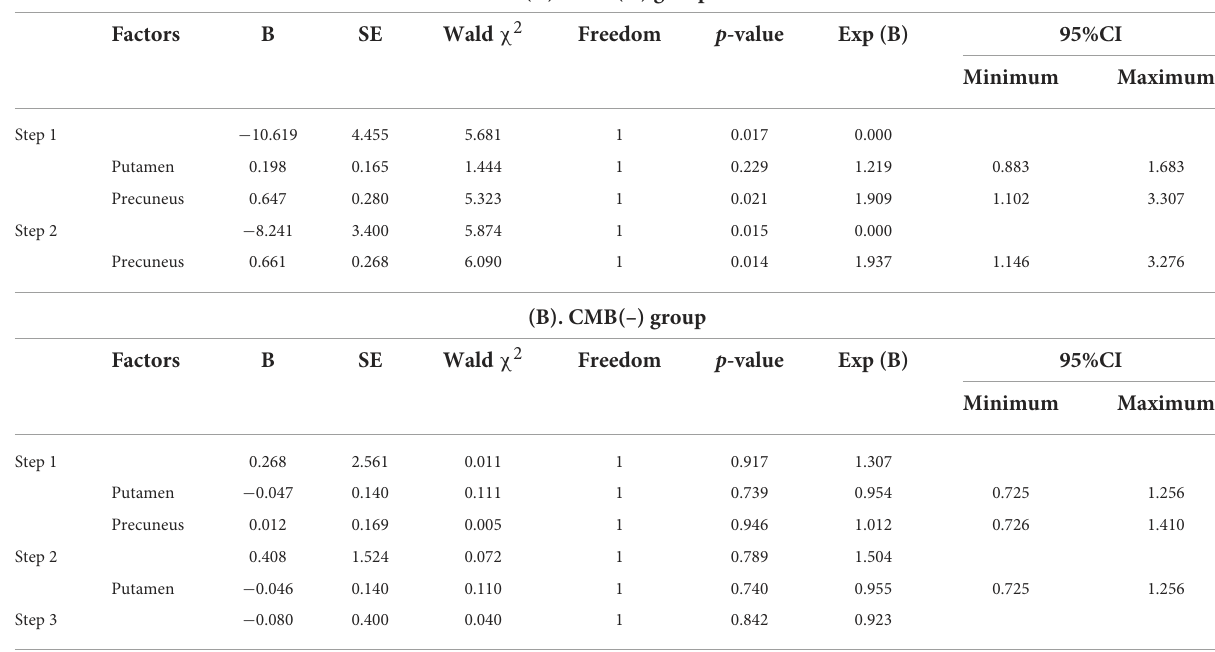
TABLE 3 The binary logistic regression analysis (backward: LR) results in iron deposition and cognitive